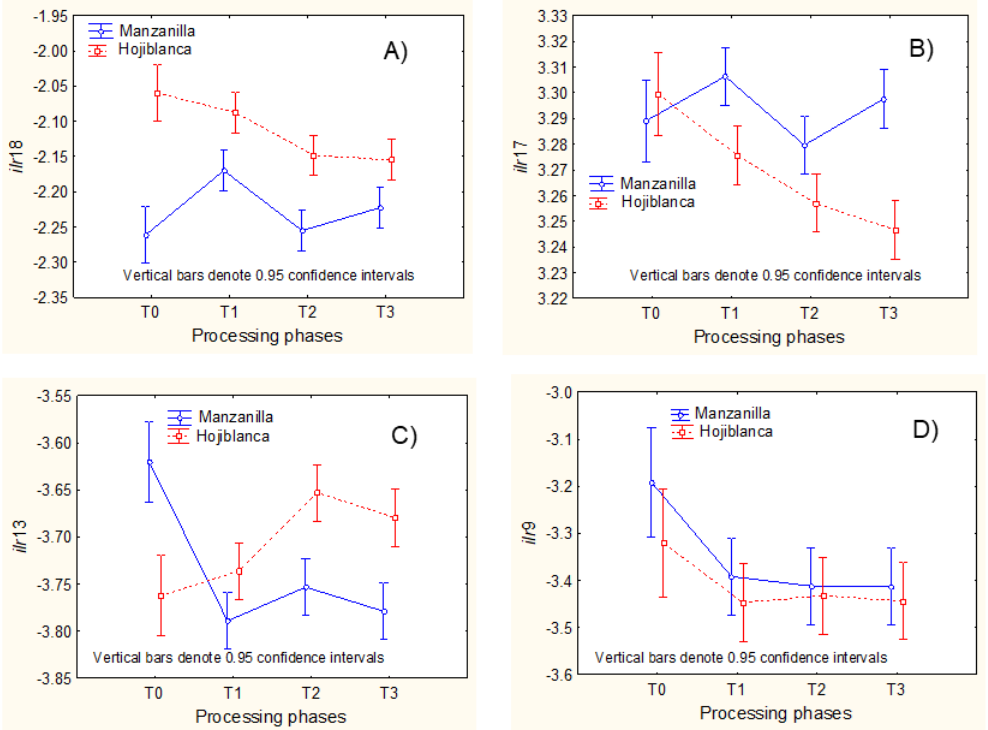
Figure 6. Examples of processing phase effects, according to cultivar, on ilr coordinates deduced from SBP using decreasing clr variance order. ( A – D ) show ilr coordinates which showed significant differences between cultivars. T0, fresh olives; T1, lye-treated olives; T2, fermented olives; T3, packaged olives.